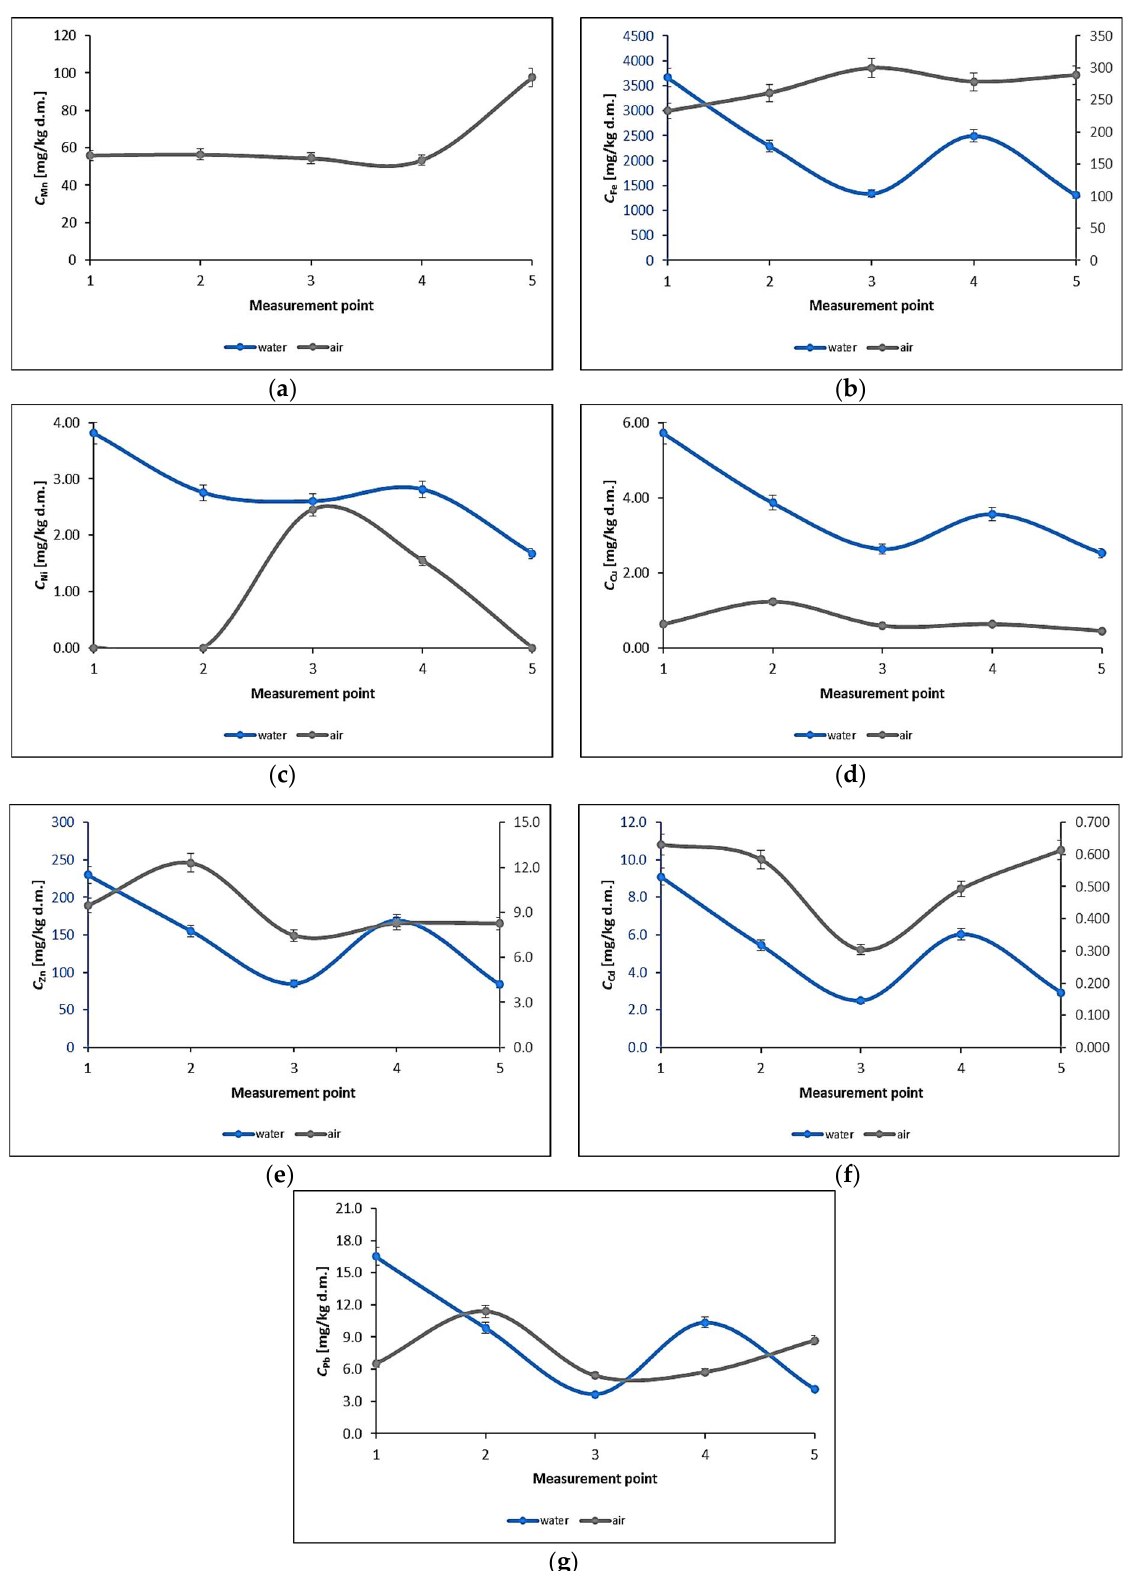
Figure 4. Changes in heavy metal concentrations of ( a ) manganese; ( b ) iron; ( c ) nickel; ( d ) copper; ( e ) zinc; ( f ) cadmium; ( g ) lead determined in P. schreberi mosses—water and atmospheric aerosol biomonitors.